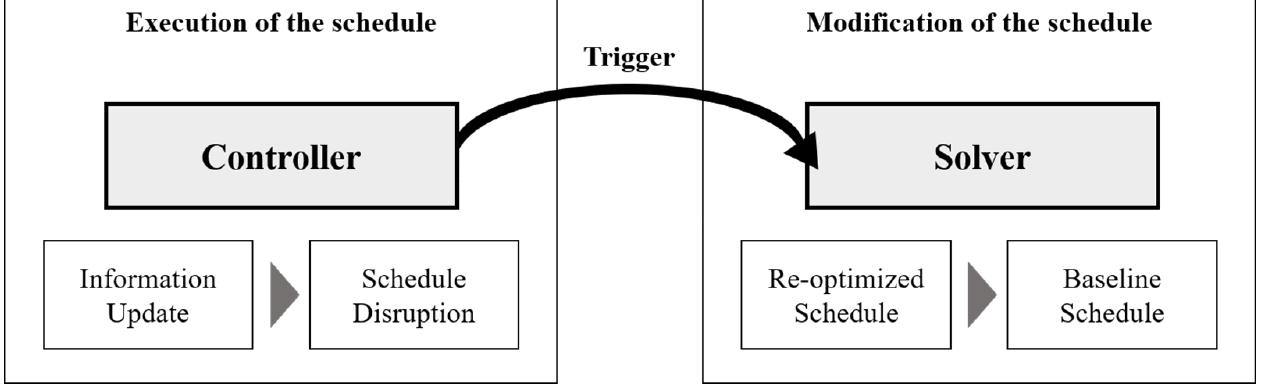
Figure 3. Conceptual framework to model a dynamic berth rescheduling problem.